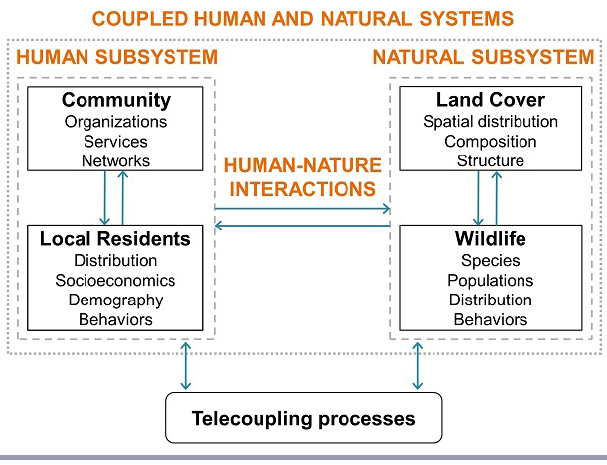
Fig. 1. General conceptual diagram of dynamic (changing across space and time) and reciprocal relationships between main components of coupled human and natural systems (CHANS) with respect to wildlife research and conservation. Human-nature interactions (wildlife impacts on people and vice versa) are weakened and/or strengthened by a number of factors and processes such as disturbances, policies, and feedbacks. Telecoupling processes (socioeconomic and environmental interactions over distances) link the focal CHANS to other distant CHANS. For simplicity, inter- relationships among subsystem characteristics are not shown. Dotted lines indicate that system boundaries are